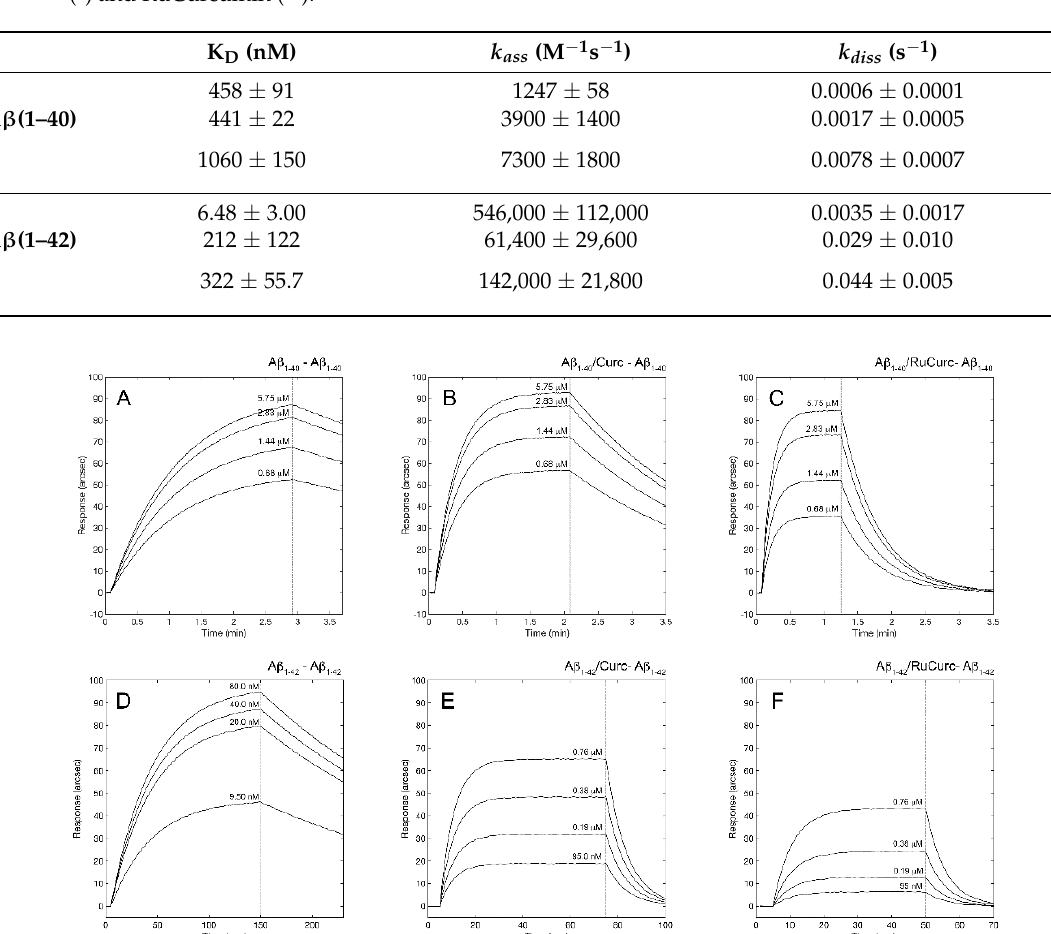
Table 2. Comparison of kinetic and equilibrium parameters for the binding of curcumin and RuCurcumin to amyloid peptides.